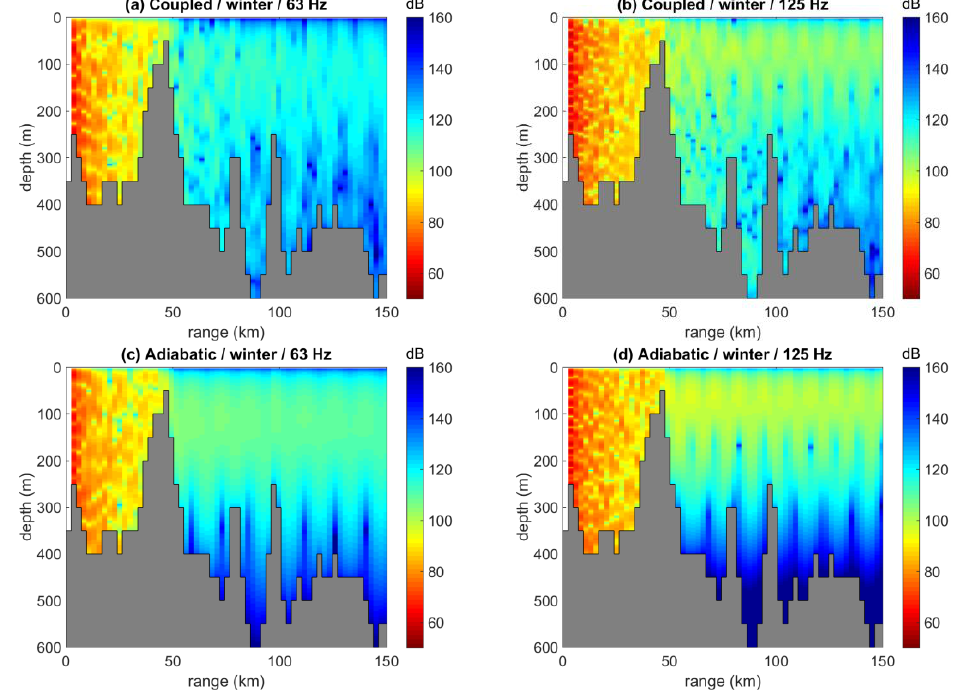
Figure 6. Transmission loss (dB) along transect AB for the winter SVP for a source depth of 5 m. ( a ) Coupled-mode results at 63 Hz; ( b ) Coupled-mode results at 125 Hz; ( c ) Adiabatic results at 63 Hz; ( d ) Adiabatic results at 125 Hz.